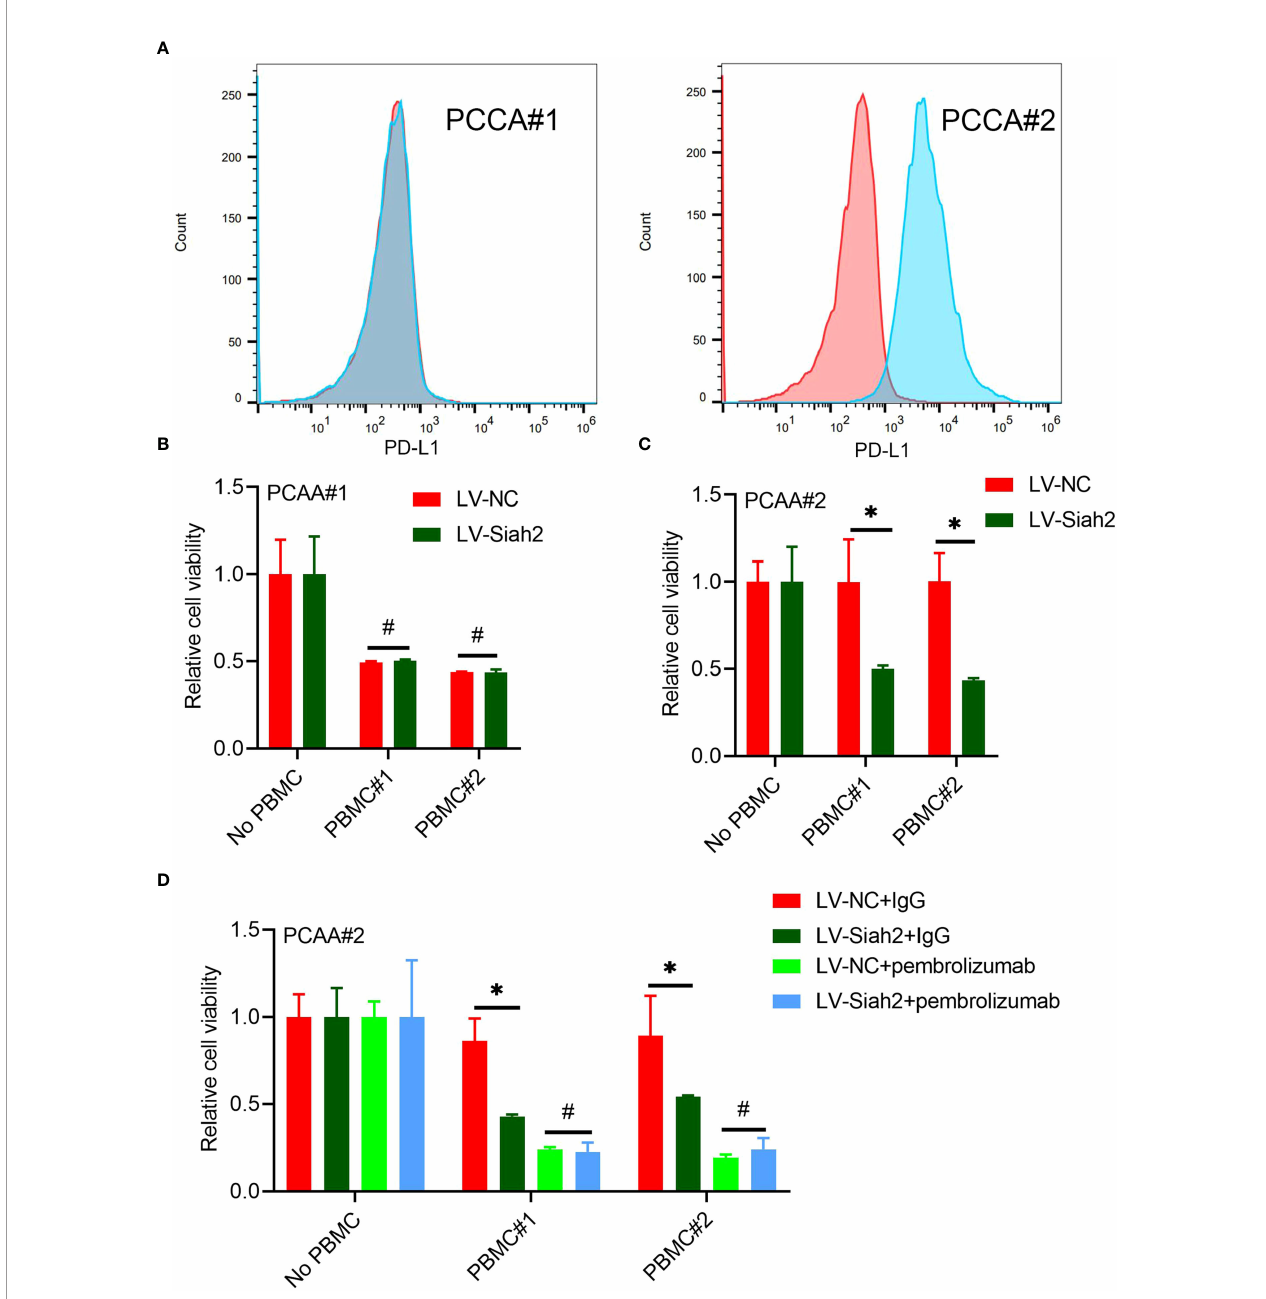
FIGURE 7 | Siah2 enhanced antitumor T-cell immunity in a PD-L1 – dependent manner. (A) , FCM detected the cell membranous PD-L1 level of PCCA#1 and #2. (B, C) , CCK8 assay detects the killing of PCAA#1 LV-NC/LV-Siah2 by activated HPBMC in PCCA#1 and PCCA#2 cells. The ratio of PBMC to tumor cell number was 4 to 1, n = 3. (D) , CCK8 assay detected the killing of tumor cells by activated HPBMC after Pembrolizumab or 10 µg/mL IgG treatment. PCAA#2-LV-NC/LV- METTL14 were co-cultured in the presence or absence of HPBMC for 24 h at the ratio of HPBMC to tumor cell number of 4 to 1, n = 3. Mean±SEM of three independent experiments. *P<0.05; # P >